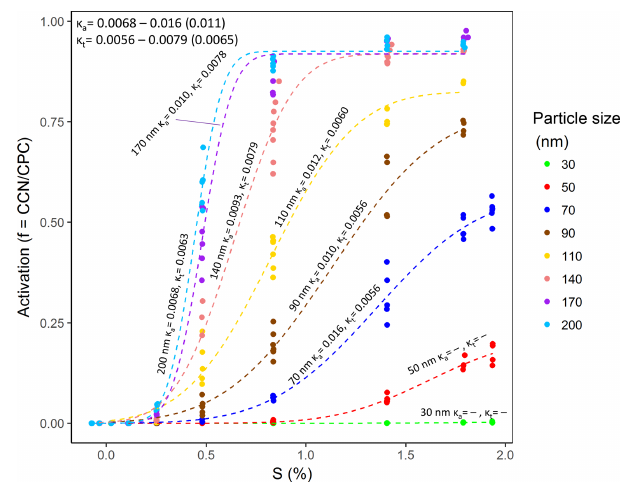
Figure 5. D 5 oxidation aerosol CCN activation curve. Size-specific κ a and κ t are tabulated for particles 70–200nm. The calculated kappa parameter range and average (in parentheses) are tabulated in the upper left. Each point represents an average 30s CCN / CPC measurement.